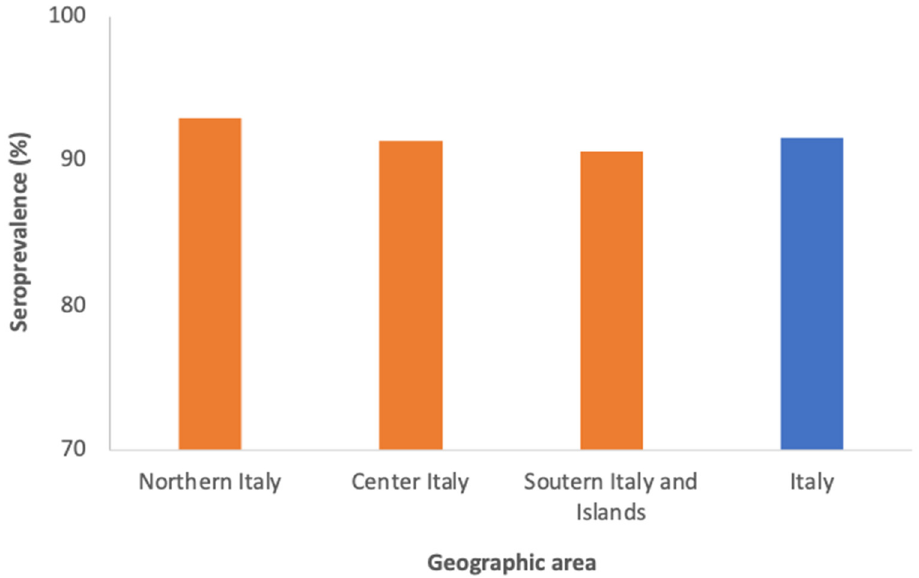
Figure 2. Seroprevalence of anti-varicella antibodies in the Italian geographical areas.